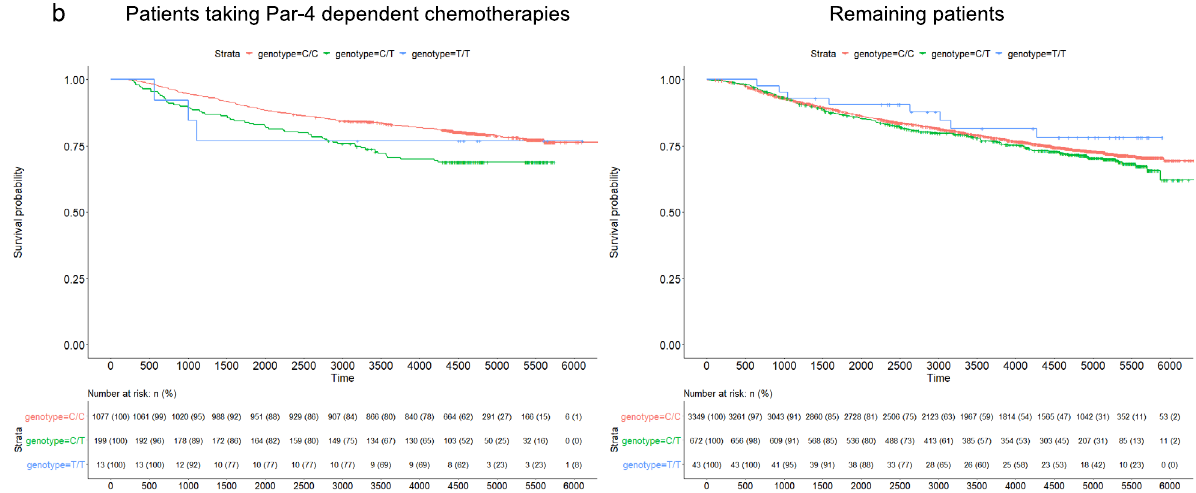
Fig. 3 Kaplan – Meier plots of rs720251. KM plot in the Pathways European population ( a ), and the SBCSS + SBCS cohort ( b ). Patients were separated by whether they took Par-4 dependent chemotherapies. Patients with imputation dosage <0.5 were considered having genotype CC. Patients with imputation dosage ≥ 1.5 were considered having genotype TT. Patients with imputation dosage in-between were considered having genotype